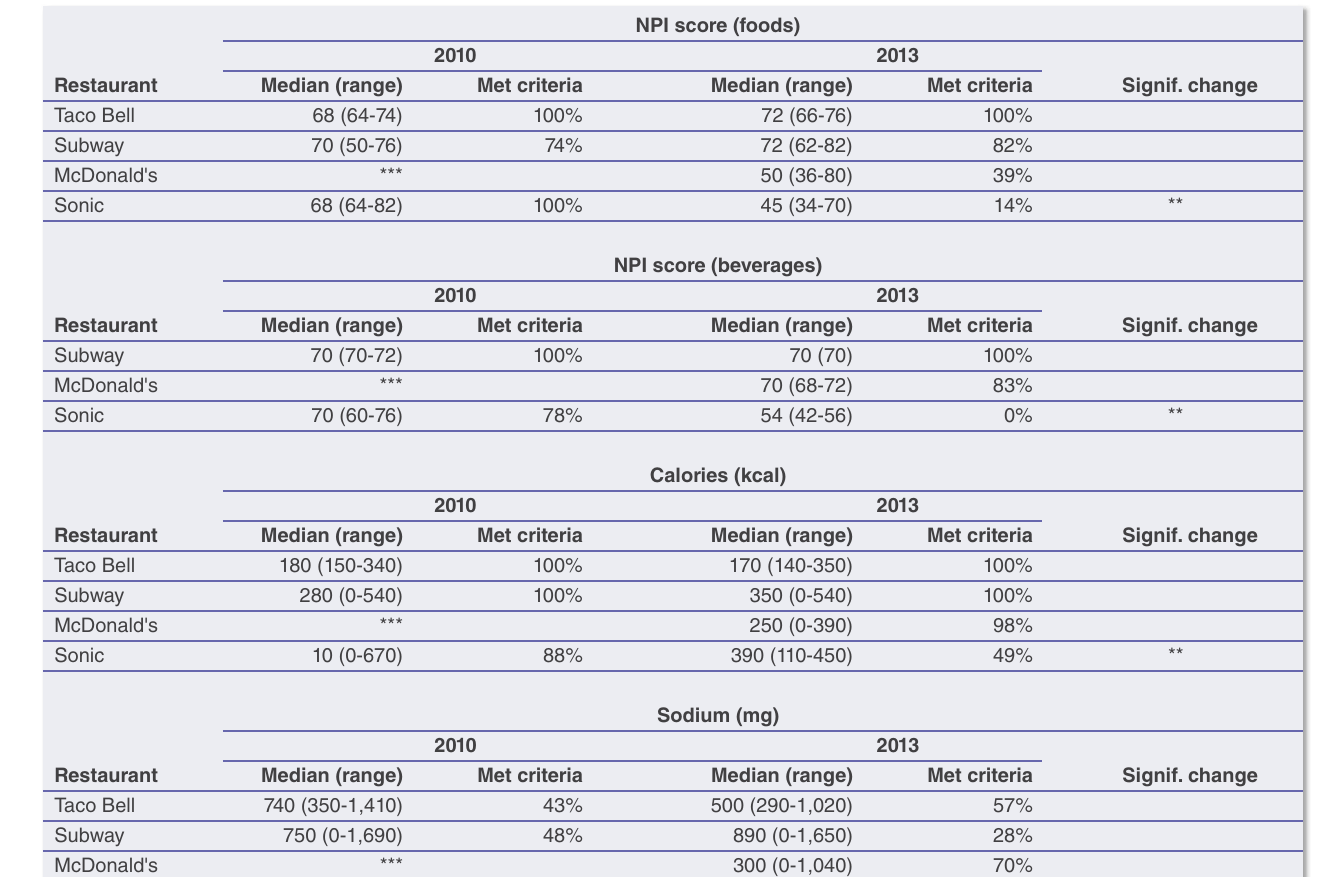
Table 14. Nutrient content of menu items available on healthy menus